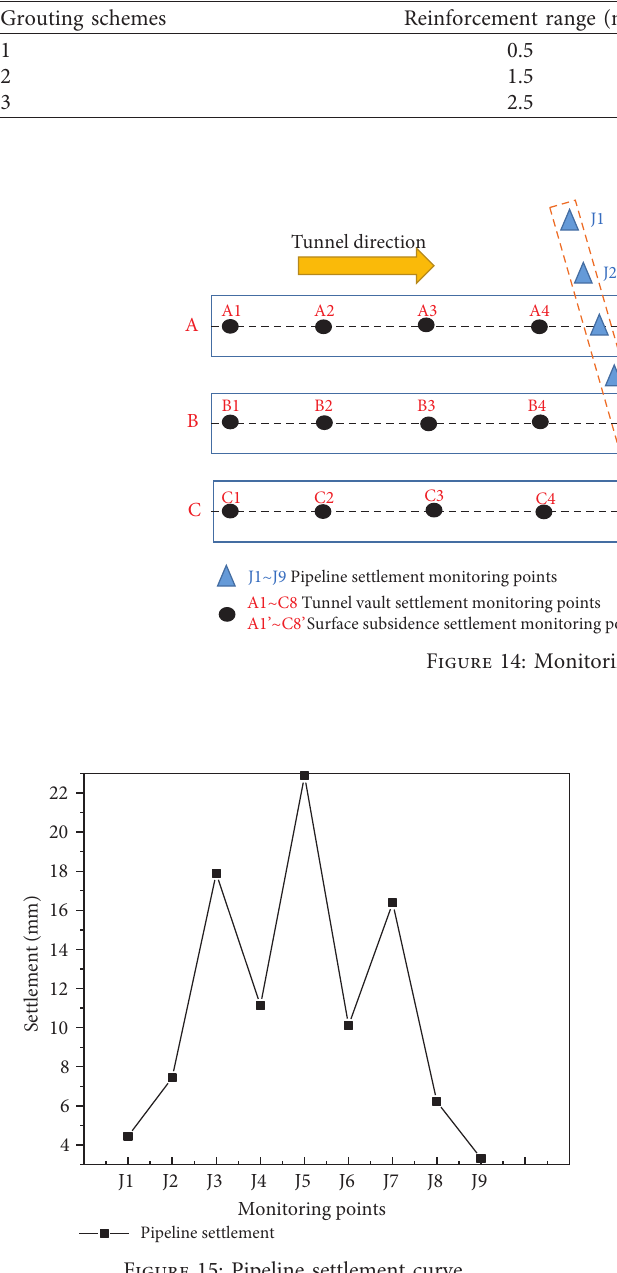
Table 6: Comparison of simulation results of construction schemes.